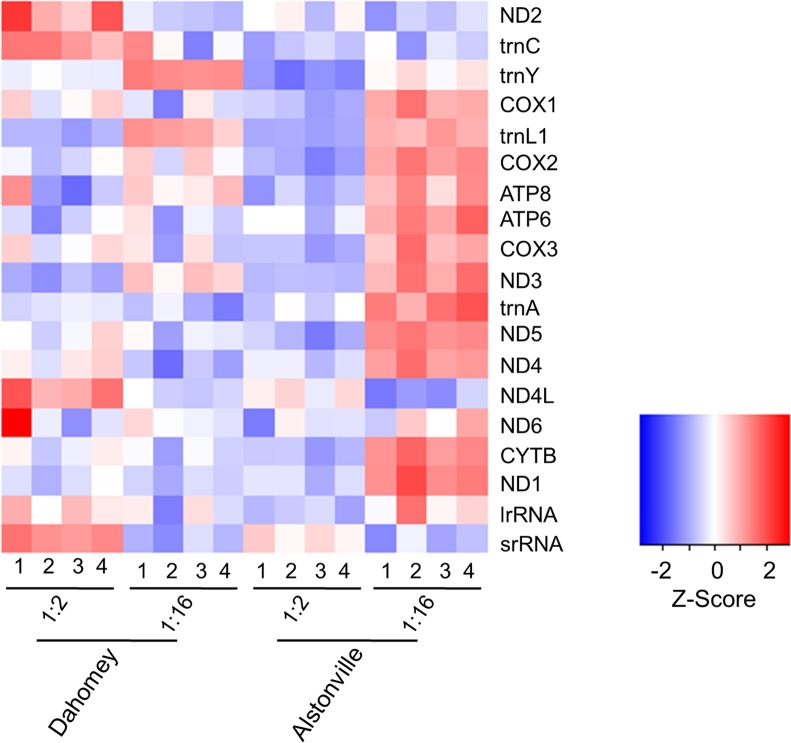
Heat map showing relative expression of mtDNA encoded genes in third instar female wandering larvae harbouring Dahomey and Alstonville mtDNA that were fed on 1:2 P:C and 1:16 P:C ratio diets.Within each treatment, there were four replicates (1–4). Log-expression values were batch corrected and standardised by gene. The darker the blue the more negative the Z score. The darker the red the more positive the Z score.